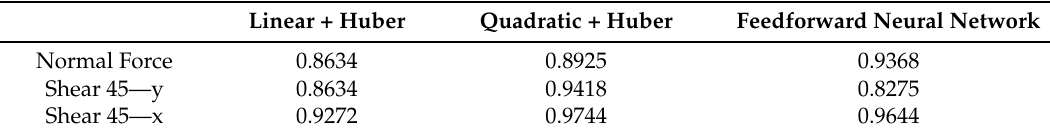
Table 1. R-squared value for the normal force and shear force experiments.